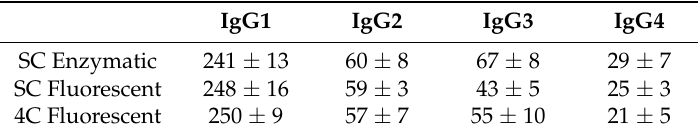
Table 1. Single-color (SC) enzymatic and SC fluorescent B cell ELISOT assays performed to detect individual IgG subclasses provide the same antibody secreting (B) cells (ASC) frequencies as the corresponding four-color (4C) ImmunoSpot ® assay. Polyclonally stimulated B cells were seeded into SC enzymatic B cell ELISPOT assays that detected the four IgG subclasses. In parallel, SC fluorescent assays were performed for each IgG subclass, and a Four Color ImmunoSpot ® assay was